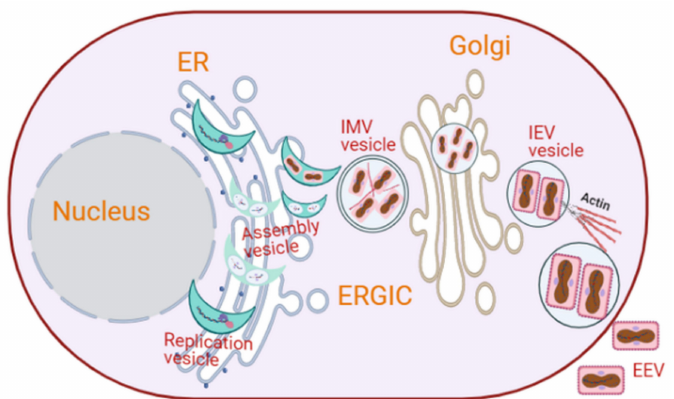
Figure 5. Intracellular membrane rearrangements induced by poxviruses. Vaccinia virus replicates in cytoplasmic crescent-shaped vesicle-like structures, resembling mini-nuclei. An intact membrane is observed around the replication organelle during DNA replication but disappears at the initiation of viral assembly. Vimentin is recruited to the replication organelle, and it facilitates virus assembly. This assembly gives rise to infectious IMVs in a double-membrane cisterna derived from the smooth ER, which later acquire single lipid membranes from the ERGIC and are subsequently wrapped by the TGN to form an IEV. While most of the vaccinia exits host cells by cell lysis, a small proportion of the IEV polymerizes actin tails, and they are released extracellularly as an EEV (image created in